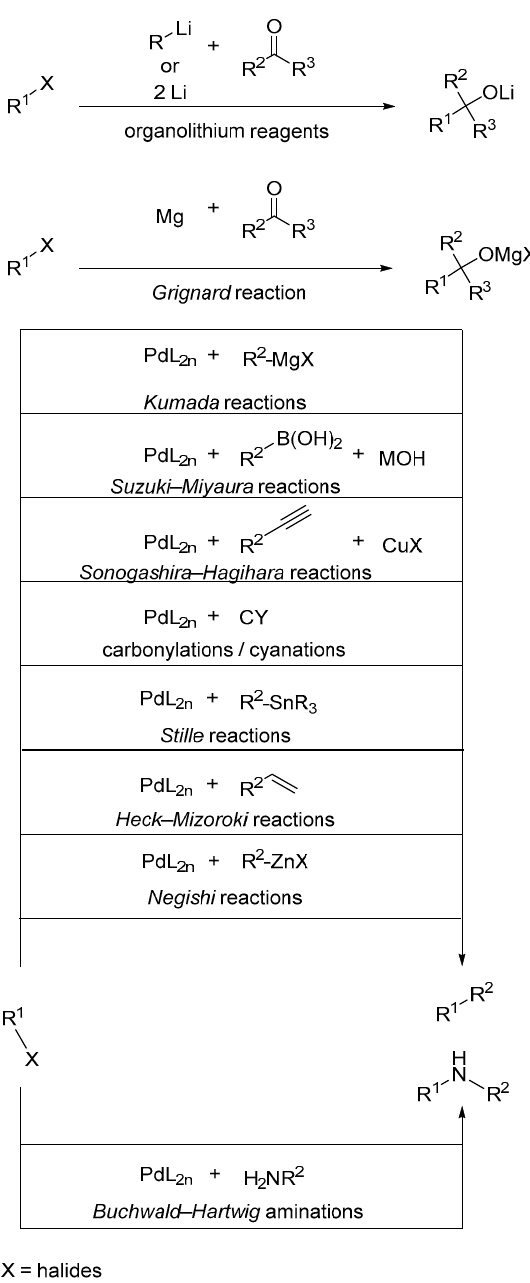
Figure 4. Most common reactions in organic synthesis exploiting halogen moieties. [37,45–48] Besides organolithium reactions as well as Grignard / Barbier reactions all of them are Pd-based, but can in many cases be substituted by other transition metals such as nickel.